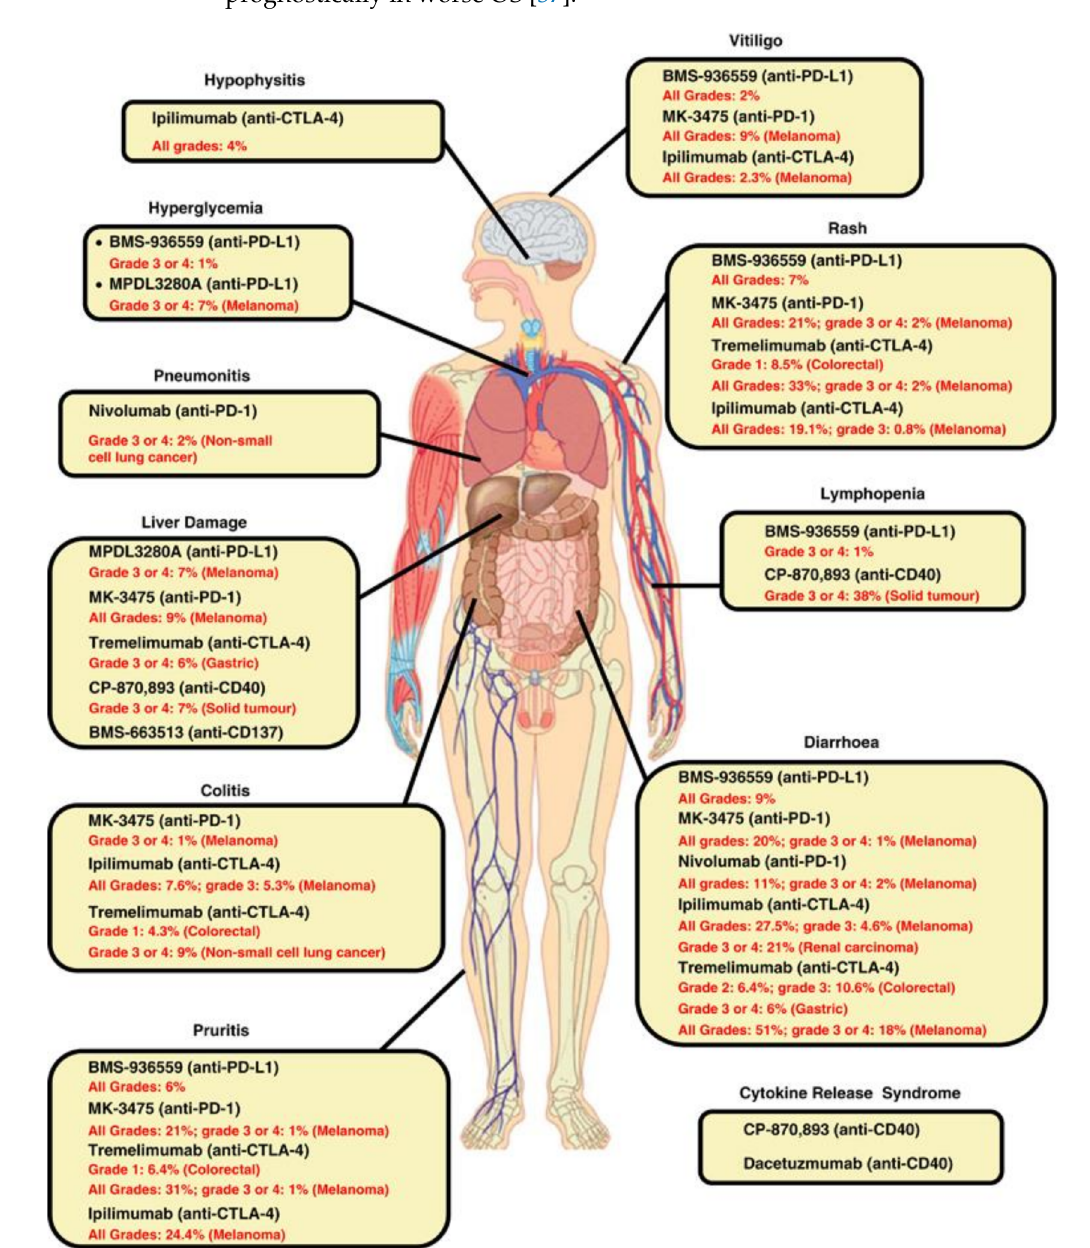
Figure 1. Spectrum of irAEs associated with immunomodulatory antibodies (available via license: Creative Commons Attribution-NonCommercial-NoDerivs 3.0 Unported, as published by Liu J, et al. Clin. Transl. Immunol. 2014, 3, e22)